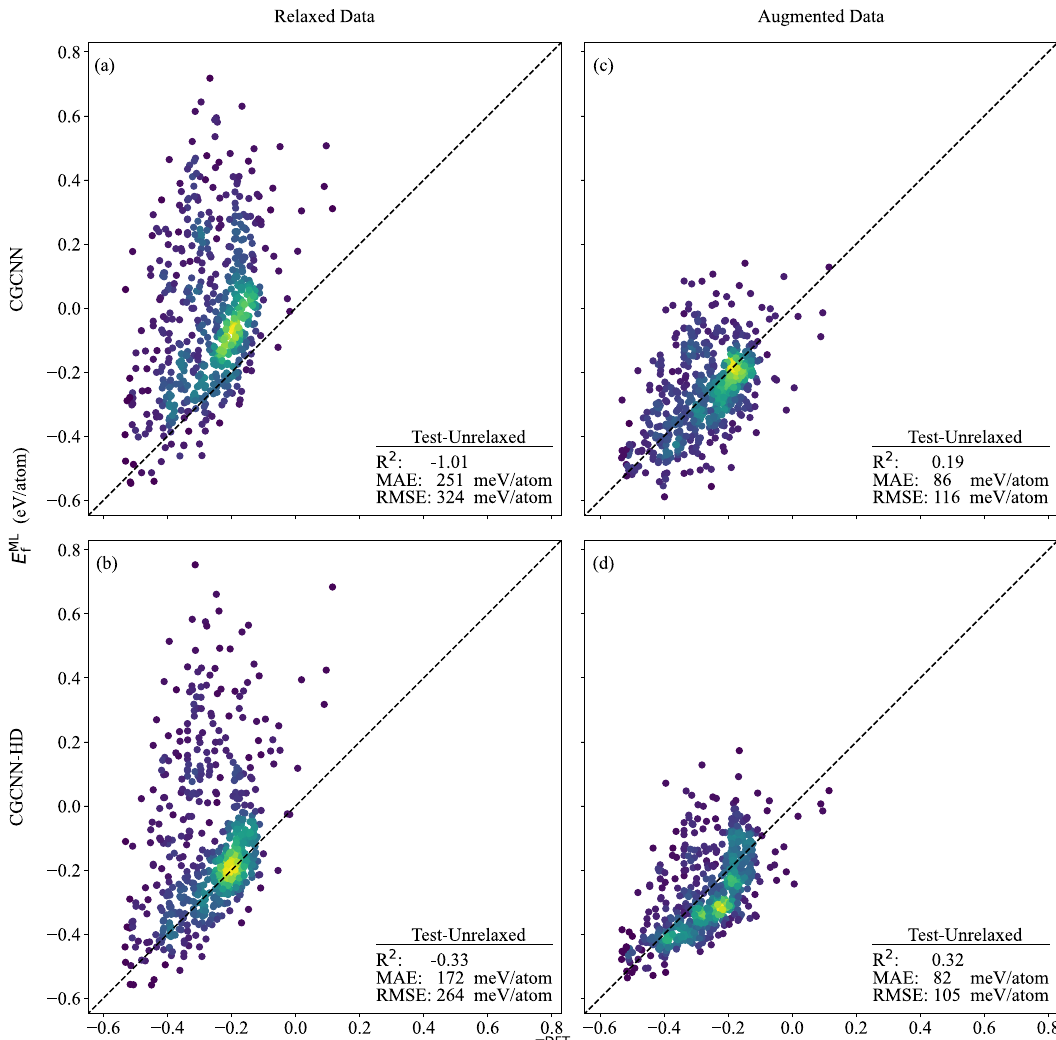
Fig. 3 Comparison of target and predicted energies of the test set of unrelaxed structures. a The CGCNN trained on relaxed data, b the CGCNN-HD trained on relaxed data, c the CGCNN trained on augmented data, d the CGCNN-HD trained on augmented data. The x -axis denotes the DFT-computed formation energies, while the y -axis denotes the predicted formation energies of the Test-Unrelaxed set. The values reported in the lower right are the coef fi cient of determination, R 2 , the MAE, and the